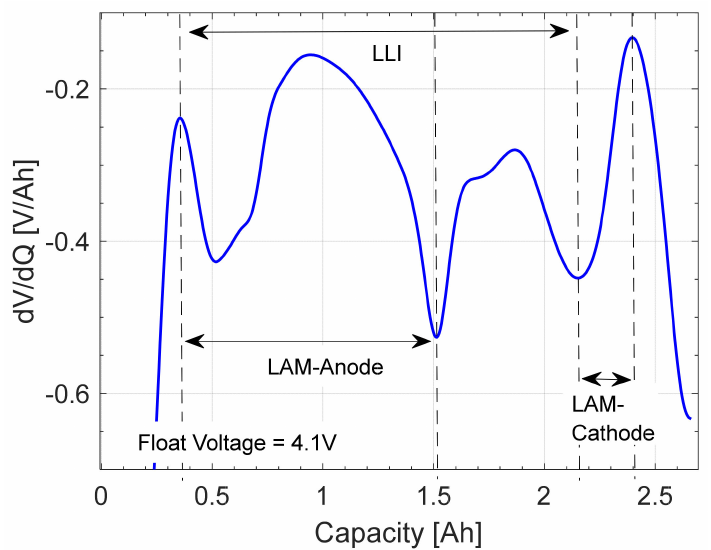
Figure 3. Exemplary dV/dQ-curve of the test cells to highlight the characteristic features of the anode and the